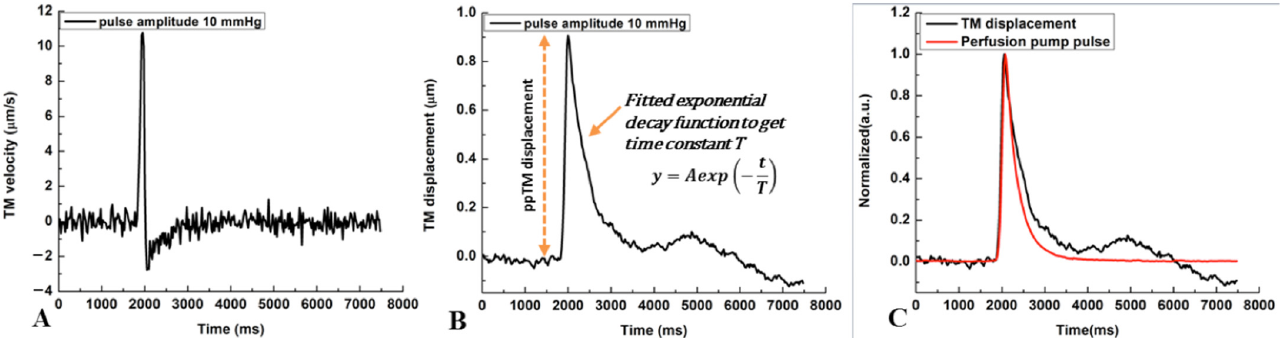
Figure 2. Representative TM velocity ( A ) and corresponding displacement trace ( B ) resulting from 10 mmHg pressure-induced pulse transients above a baseline of 16 mmHg IOP in the human eye. The peak-to-peak TM displacement ( B , dashed arrow) and recoil response ( B , small solid arrow) were used for quantitative analysis of the data. The red line in graph ( C ) represents the normalized pressure recorded by the pressure transducer overlaid on the corresponding normalized displacement recorded by OCT (black line).